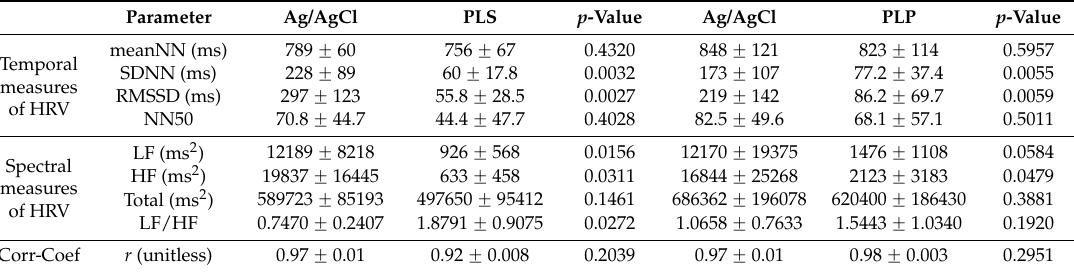
Table 8. Electrocardiogram signal quality—saltwater wet